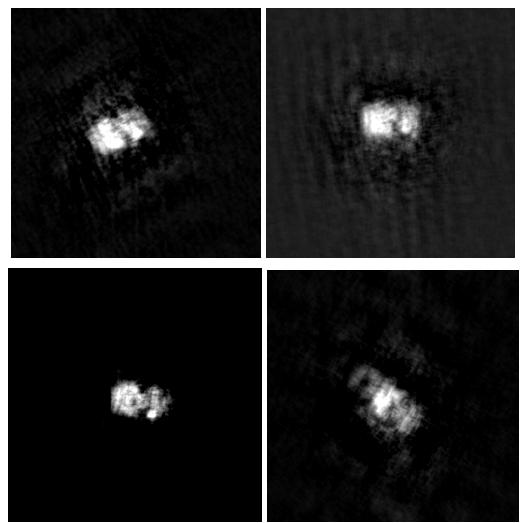
Figure 15. Images subsequently restored through 25 accumulation frames in the culmination area